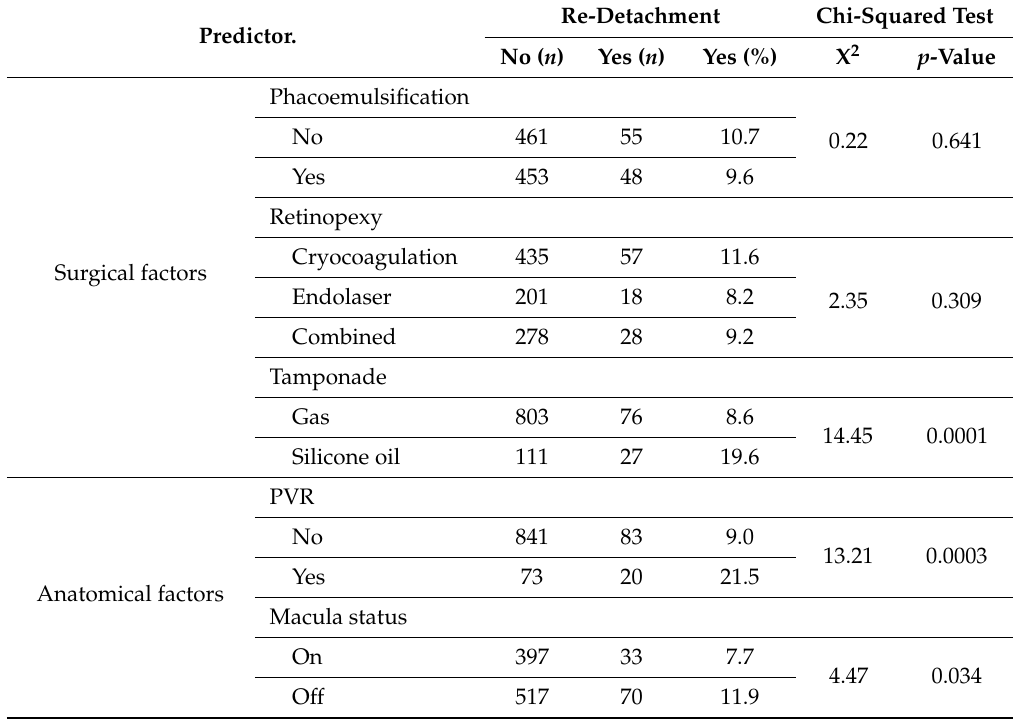
Table 1. Patients’ characteristics and associations between the occurrence of re-detachment and type of retinopexy, risk factors (primary PVR, silicon oil) and patient’s characteristics (macula status).